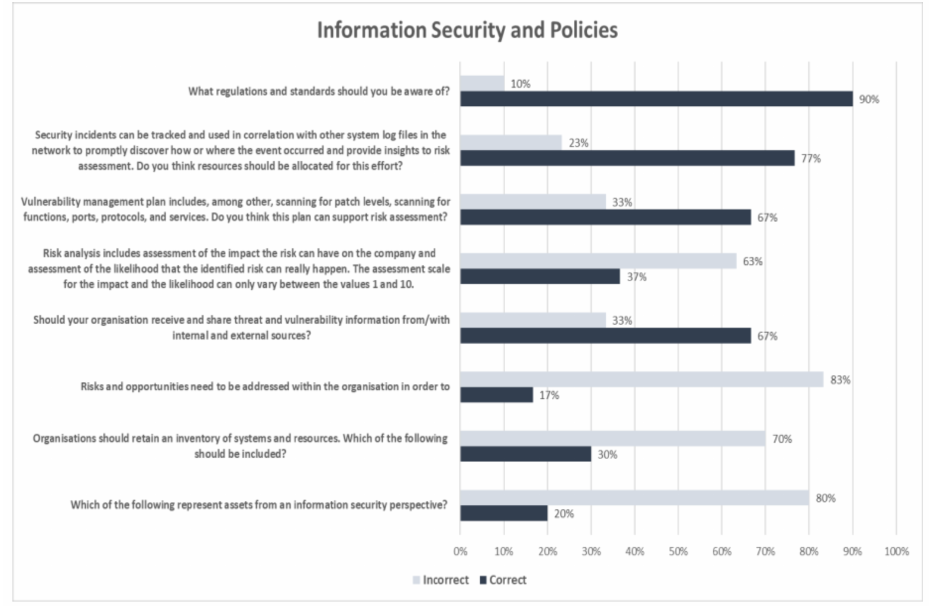
Figure 3. Evaluation of the Information Security and Policy